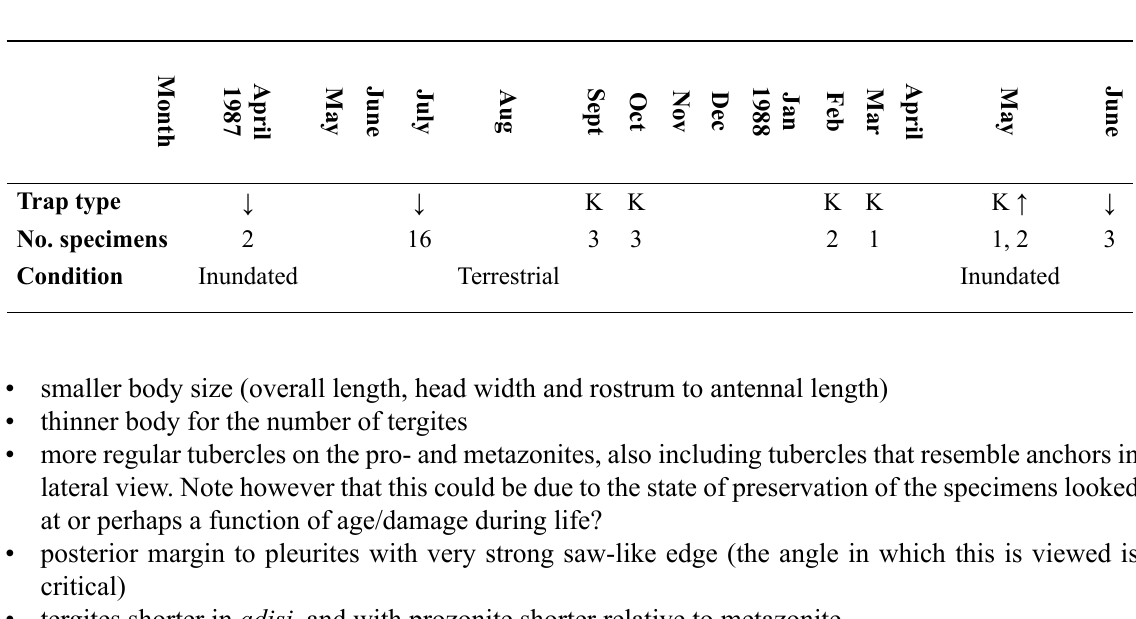
Table 2. Dates and collections of Columbianum adisi sp. nov. Key: arrow down = caught going down tree trunks; arrow up = caught going up tree trunks; K = collected from Kempson extractors from